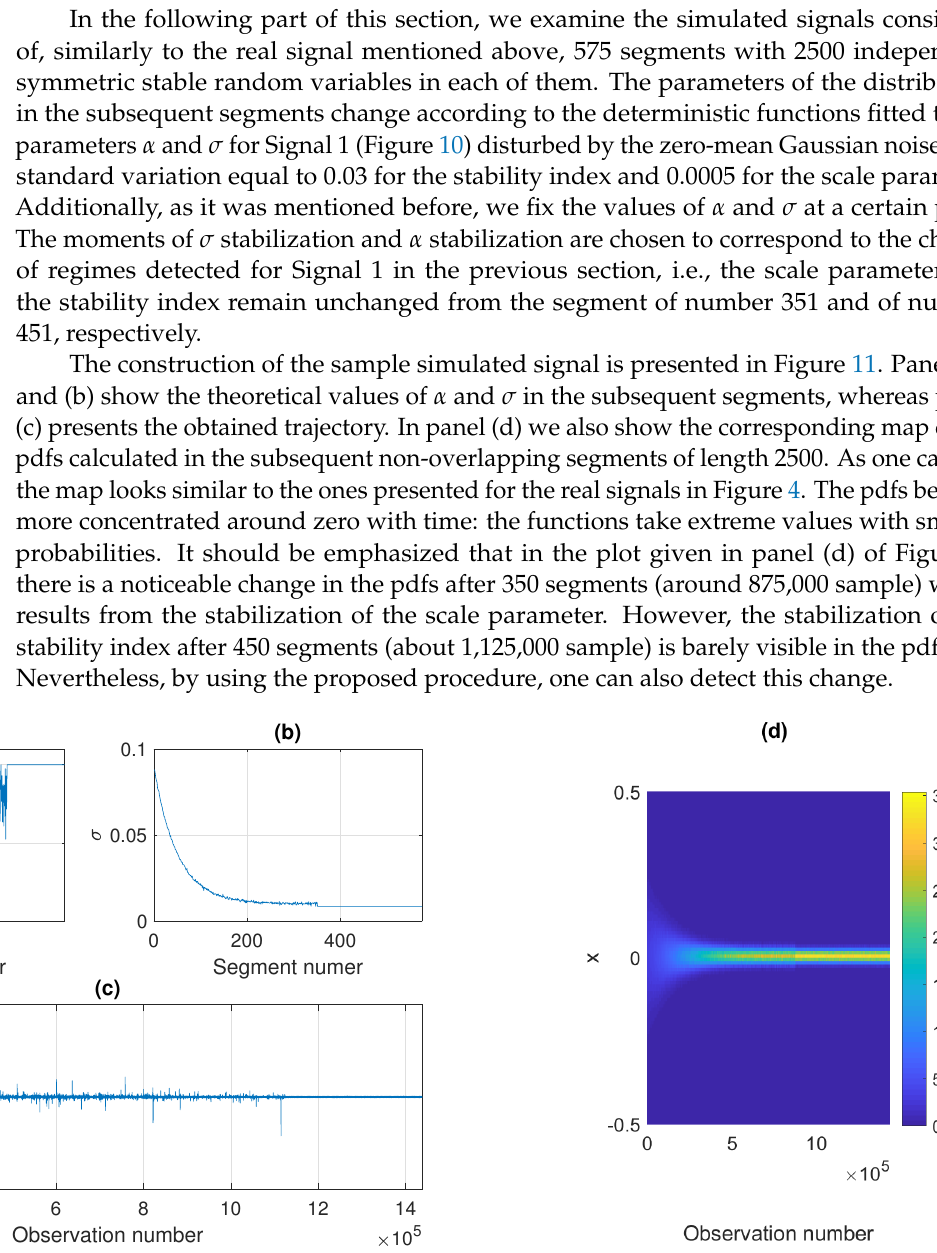
Figure 11. Values of α (panel ( a )) and σ (panel ( b )) in the subsequent segments of length 2500, the obtained simulated signal (panel ( c )), and the corresponding probability density map (panel ( d